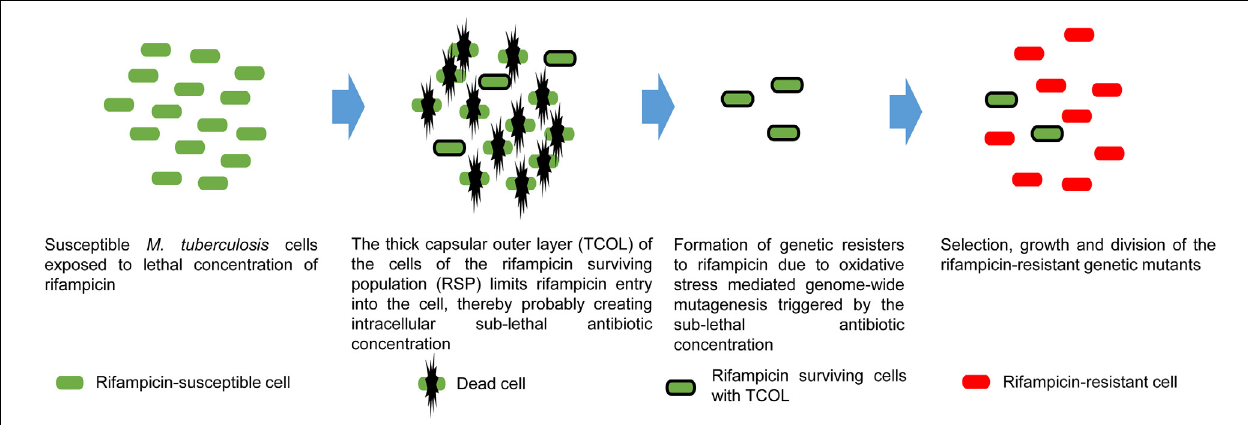
FIGURE 6 | Proposed model on the benefit of TCOL in the generation of rifampicin genetic resisters from the M. tuberculosis cells of the rifampicin surviving population (RSP). M. tuberculosis cells (green) are exposed to lethal concentrations of rifampicin that kills susceptible cells. The cells of the RSP develop TCOL that restricts rifampicin permeability into the M. tuberculosis cells of the RSP, resulting in sub-lethal intracellular concentration of rifampicin. The presence of intracellular rifampicin invokes oxidative stress due to reactive oxygen species (hydroxyl radical) generation that inflicts genome-wide mutagenesis. This leads to the de novo emergence of antibiotic-resistant genetic mutants (red), as demonstrated by us (see Sebastian et al., 2017). The model represents a synthesis of the data from the present study and from Sebastian et al. (2017).